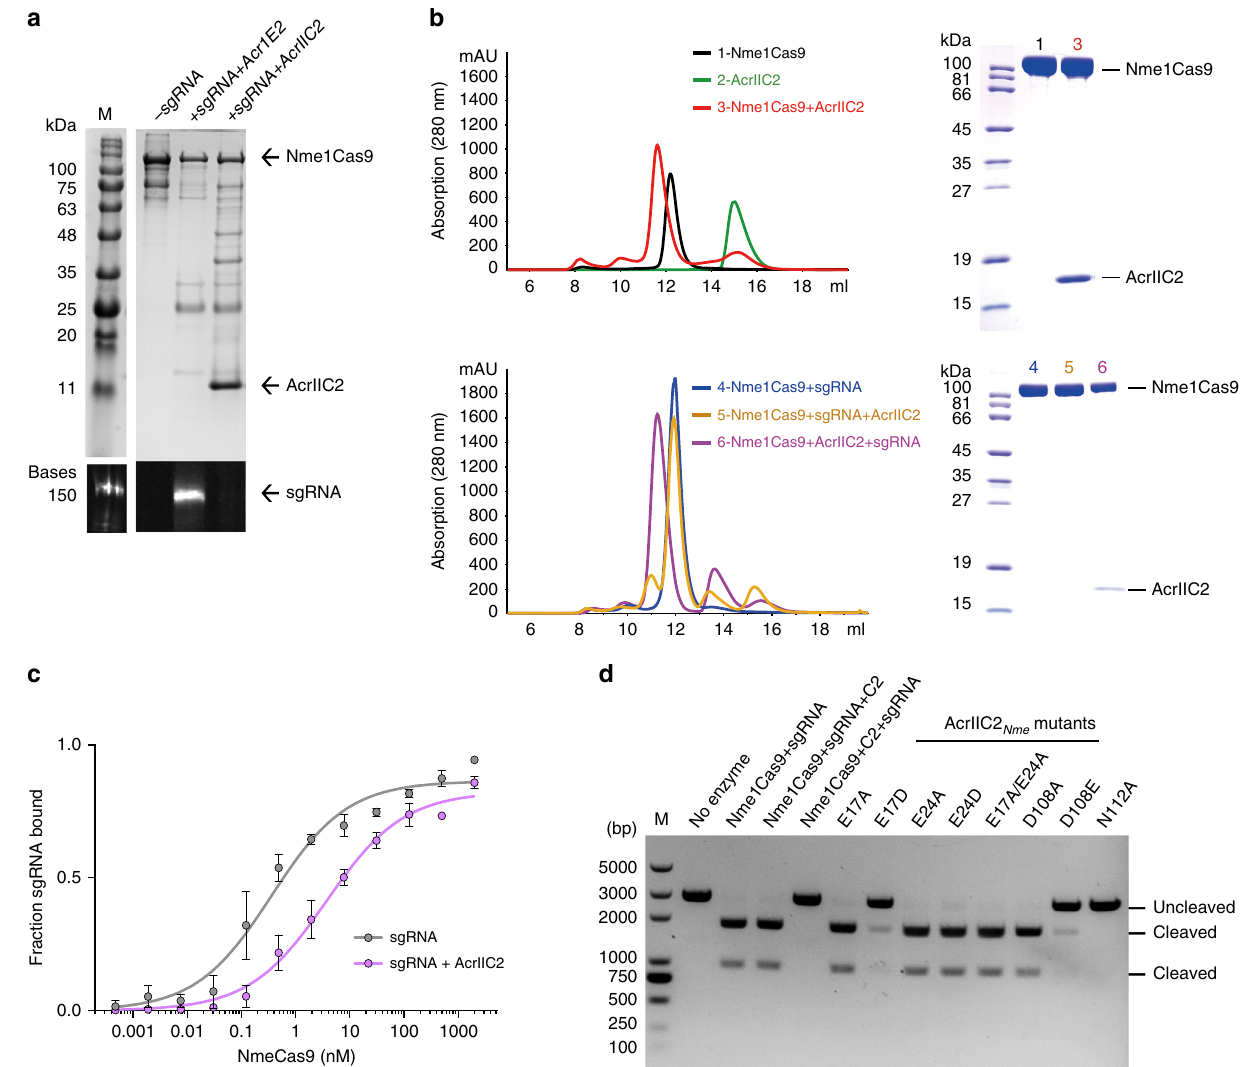
Fig. 2 AcrIIC2 Nme inhibits sgRNA binding. a Puri fi cation of His-tagged Nme1Cas9 + sgRNA co-expressed with AcrIIC2 Nme or a type I anti-CRISPR protein (AcrIE2) using Ni-NTA chromatography. Analysis of the resulting elutions included SDS-PAGE followed by Coomassie staining (upper panel) and denaturing polyacrylamide/urea gel followed by SYBR Gold staining (lower panel). b Gel fi ltration chromatography shows that AcrIIC2 Nme interacts with sgRNA-free Nme1Cas9 (upper panel), but fails to bind to the Nme1Cas9-sgRNA complex (lower panel). The Nme1Cas9-sgRNA-AcrIIC2 Nme and Nme1Cas9-AcrIIC2 Nme -sgRNA samples were reconstituted by incubation of puri fi ed Nme1Cas9, sgRNA, and AcrIIC2 Nme at a molar ratio of 1:1.3:4 on ice. Each component was added in the order listed, with an intermittent incubation of 30 min before adding the next component. All samples were fractionated on a Superdex 200 increase 10/300, and fractions between 11 and 13 mL were analyzed on SDS-PAGE. c Radiolabeled RNAs were incubated with increasing amounts of Nme1Cas9 in the absence (gray) or presence (purple) of AcrIIC2 Nme , and the fraction of protein-bound RNA was determined by nitrocellulose fi lter binding. Source data are provided as a Source Data fi le. d DNA cleavage assays with Nme1Cas9 and AcrIIC2 Nme . The components and order of addition are noted above each lane. The AcrIIC2 Nme mutants were mixed with Nme1Cas9 before adding the